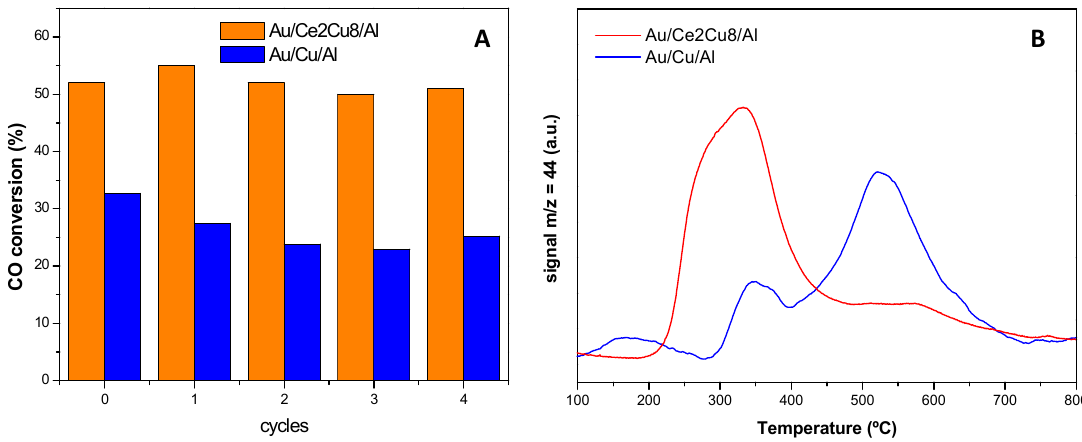
Figure 11. ( A ) Start ‐ up/shut ‐ down stability. Reaction conditions: 50% H 2 ; 12% CO 2 ; 30% H 2 O; 11% CO after the long ‐ term stability test at 280 °C. ( B ) CO 2 ‐ TPD profiles of the spent catalysts after the start ‐ up/shut ‐ down test. Reproduced with permission from [144]. Copyright Elsevier, 2016.